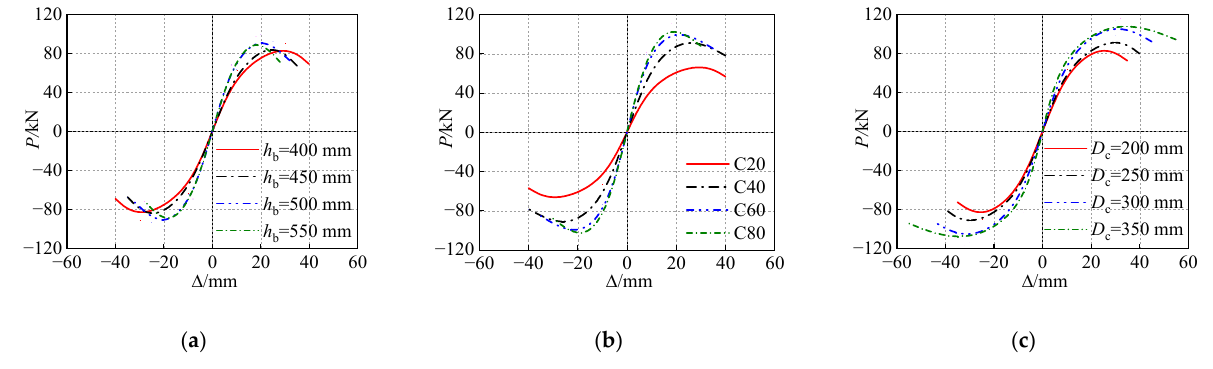
Figure 17. Effects of various parameters on the numerical skeleton curves. ( a ) Joint heigh. ( b ) Joint concrete strength. ( c ) Joint diameter.